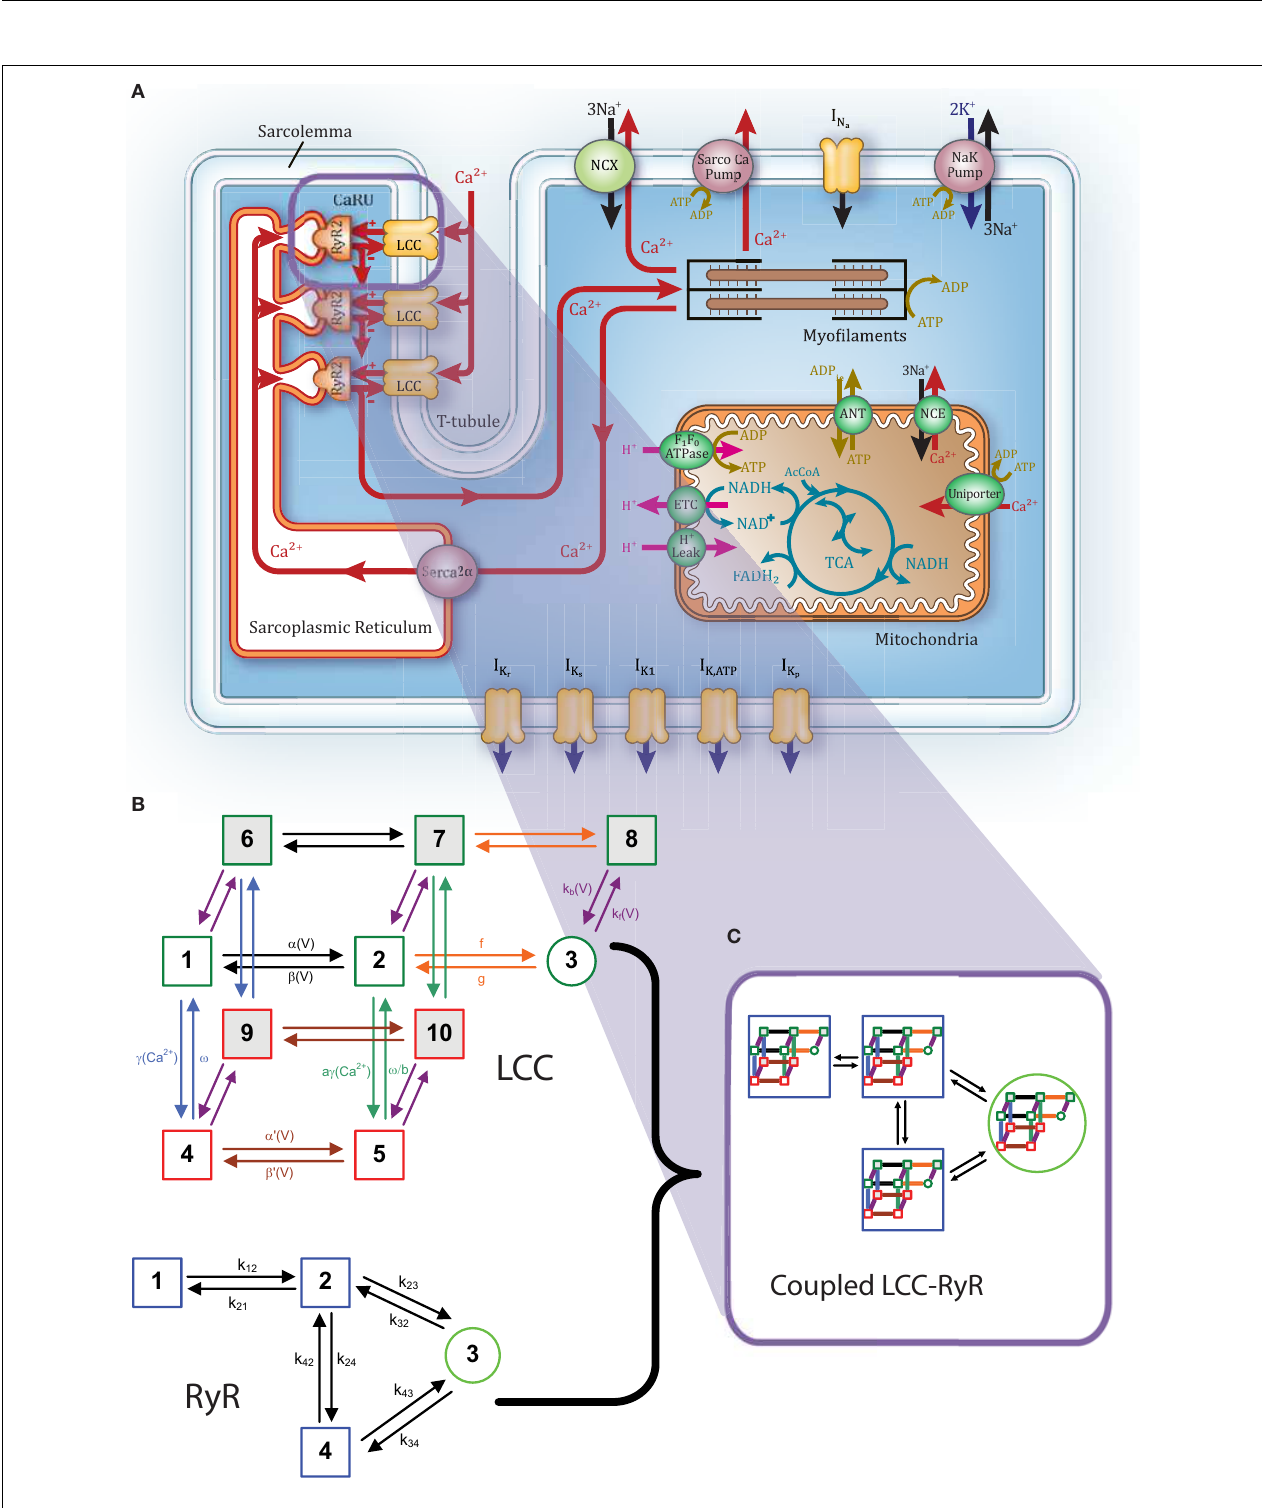
FIGURE 1 | Overview of guinea pig coupled model. (A) Schematic illustration of the model structure. (B) LCC (top) and RyR (bottom) Markov model structures. (C) The 40-state LCC:RyR model representing each possible pairing of LCC and RyR states.